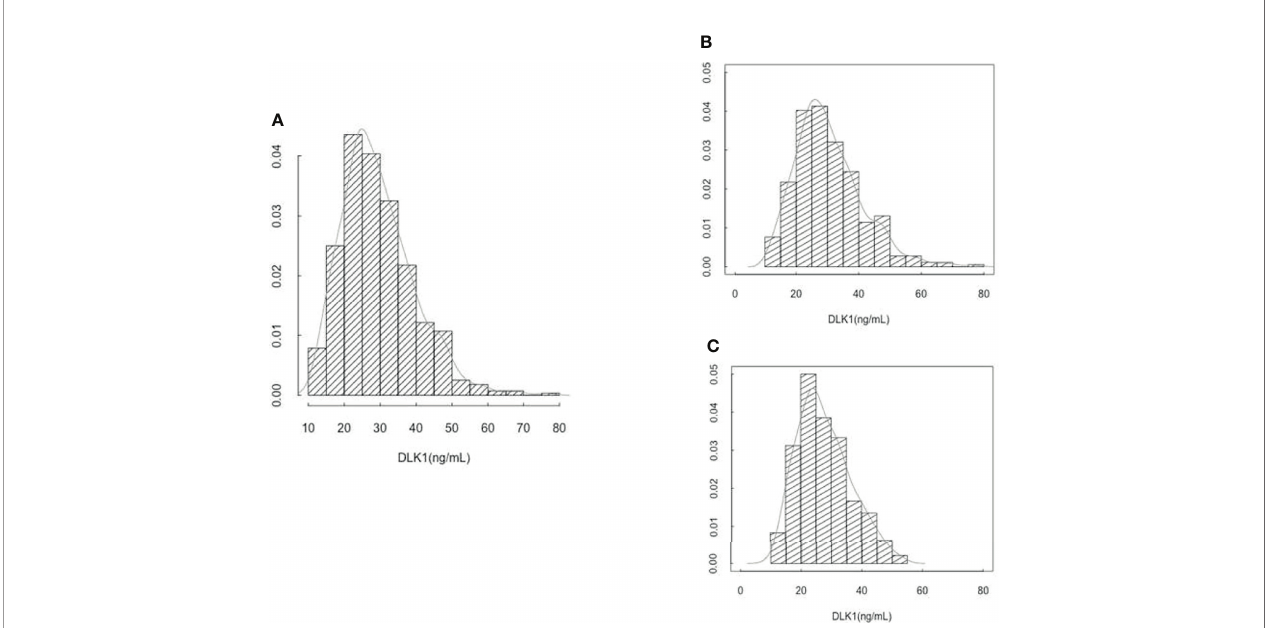
FIGURE 1 | (A) Distribution of circulating DLK1 levels at 26 weeks of gestation in 560 EDEN mothers. (B) Distribution of circulating DLK1 levels at 26 weeks of gestation in 368 mothers who gave birth to AGA newborn. (C) Distribution of circulating DLK1 levels at 26 weeks of gestation in 192 mothers who gave birth to SGA